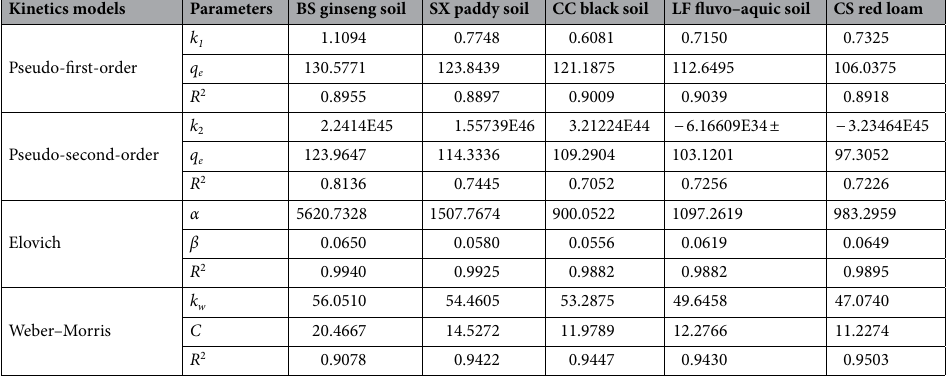
Table 3. Constants and correlation coefficients for the kinetics models.